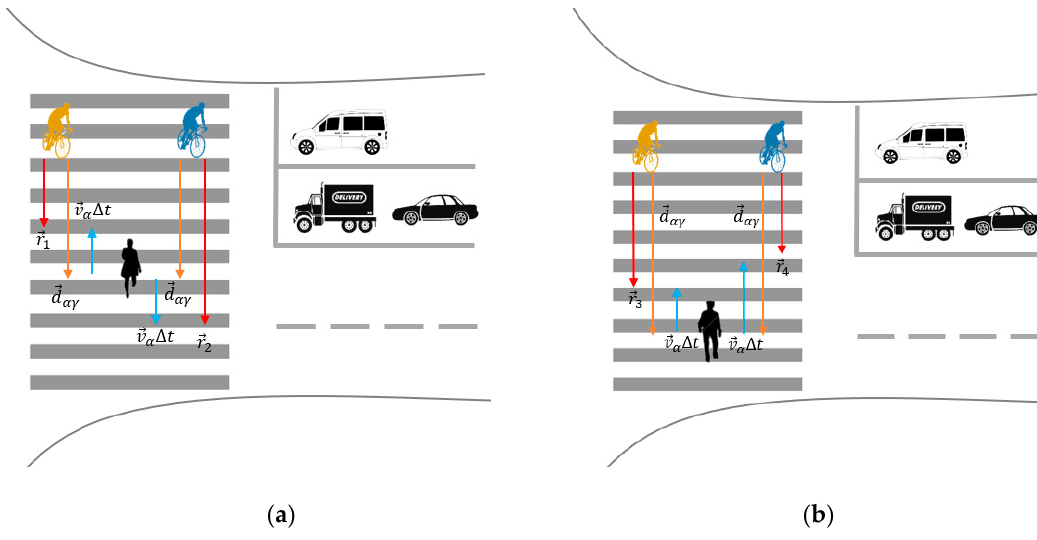
Figure 5. The interaction of a pedestrian and cyclists. ( a ) Scenario 1: pedestrian α moves in the same or opposite direction of cyclists r_1 and r_1, respectively. ( b ) Scenario 2: pedestrian α moves toward cyclists with two different speeds.